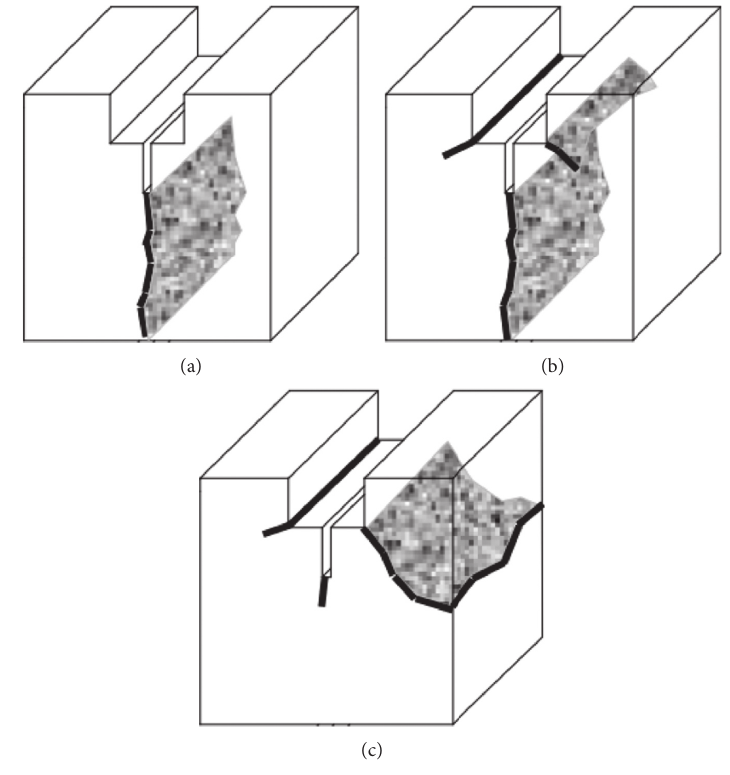
Figure 3: The failure pattern